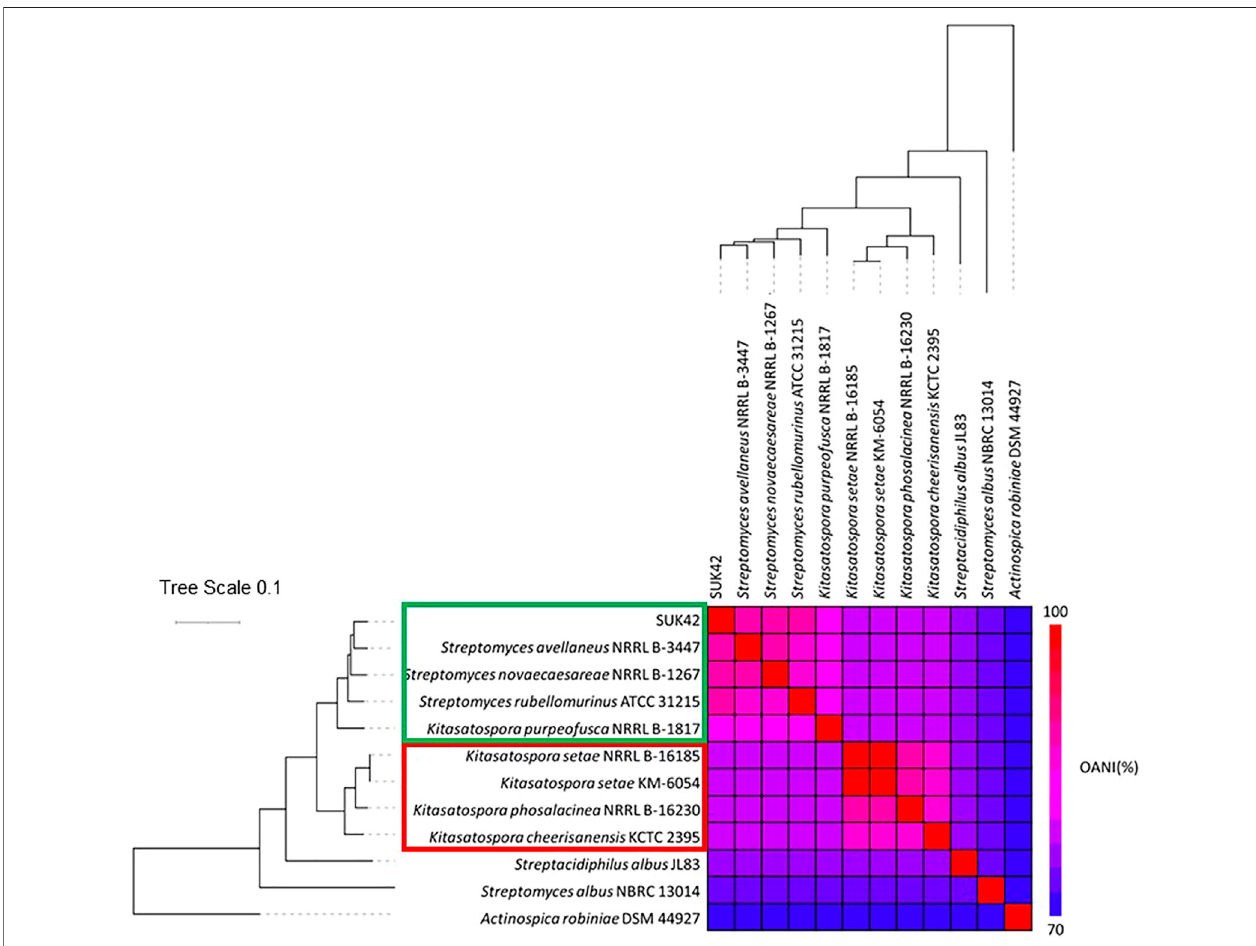
FIGURE 2 | Phylogenetic relationship of putative members of the genus Kitasatospora. Eight strains with > 84.7% ANI with Kitasatospora sp. SUK42 and appropriate type were used to carry out Multi-Locus Sequence Analysis (MLSA) to produce a high-resolution species tree using AutoMLST after a concatenated alignment (Alanjary et al., 2019). All branches were supported with boot strap values of 100 except the Kitasatospora sp. SUK42/S . avellaneus node shared with S. novoceasaereae (82). The average nucleotide identities (ANI) was calculated using the OrthoANI tool (Lee et al., 2016) and plotted with the heat map function in R (Ver. 4.0). Actinospica robiniae , type strain of the family Actinospicaceae and the type strains of the genera Streptomyces and Streptacidophilus , S. albus NBRC 13014 and S. albus JL83, respectively, were used as